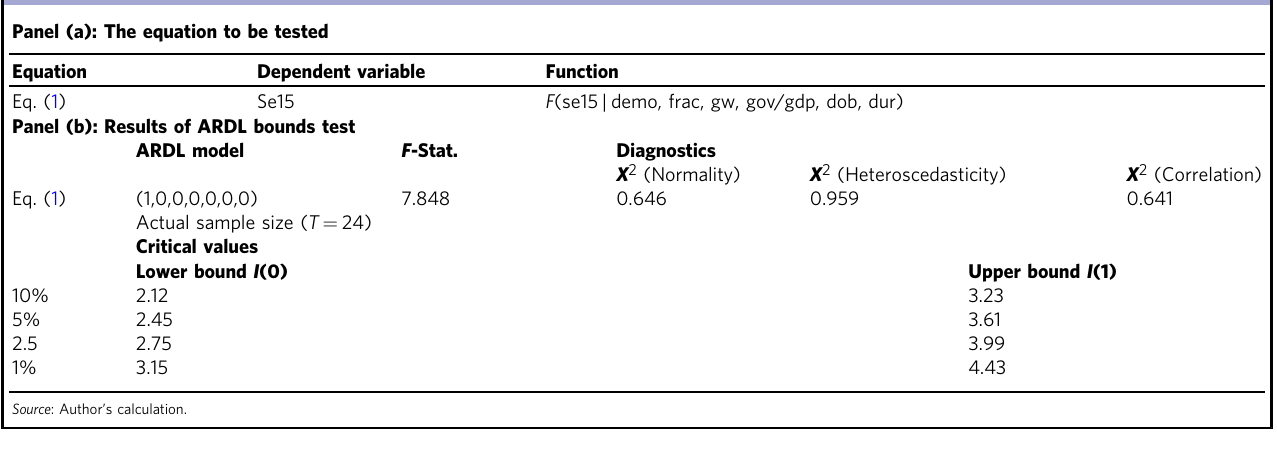
Table 2 Results of the ARDL bounds